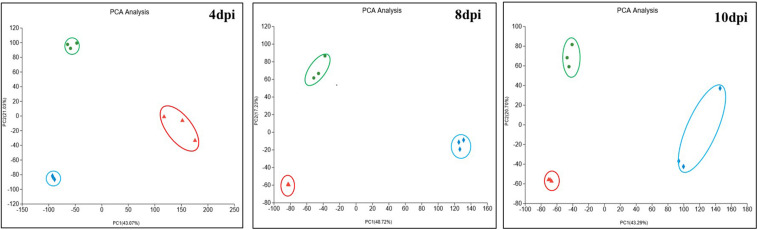
Principal component analysis (PCA) of the samples from the three groups at 4, 8, and 10 dpi used ropls (R, Version 1.6.2) in the stats package with default parameters. Blue diamonds represent samples without added FeCl3 (0Fe), green circles represent the treatment group with 20 μmol/L FeCl3 added (DC), and red triangles represent the treatment group with 400 μmol/L FeCl3 added (HFe).